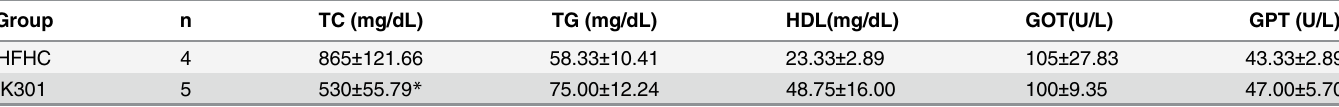
O stained area of the en face view of aorta specimen was 18.1 ± 5.6% in the reference group treated with HFHC only and was decreased by 42.3% in the K301-treated group ( P < 0.05) (Fig 7A). The Oil Red O stained area in the aortic sinus of ApoE -/- mice was decreased by 60.2% in the L . acidophilus K301-treated group compared with the reference group at 16 weeks (Fig 7B), indicating that administration of L . acidophilus K301 prevented atherosclerotic lesion development by inhibiting lipid accumulation in the aorta of HFHC-fed ApoE -/- mice. Staining of MOMA-2, a specific marker of mouse macrophages, revealed that the area of macrophage